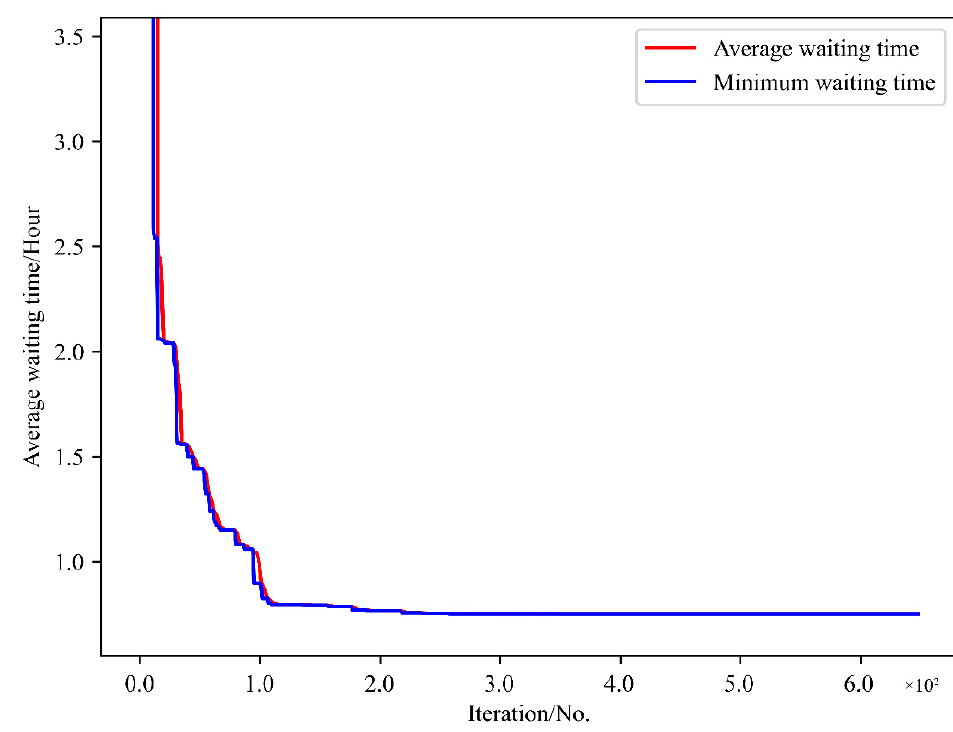
Figure 11. Iteration convergence diagram of instance “Inst_18_1”.